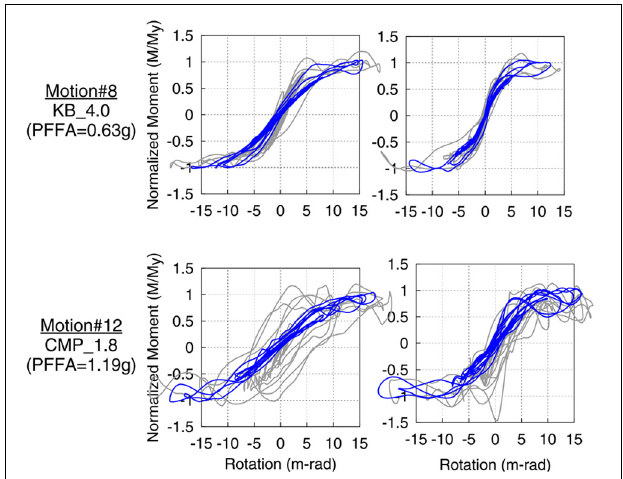
FIGURE 9 | Hysteretic rocking response of shear wall footings during shaking with two for two input motions: measured response based on inverse analyses of sensor data (gray lines) and simulated responses from finite element analyses (blue lines) (Reproduced from Liu et al., 2015b with permission from